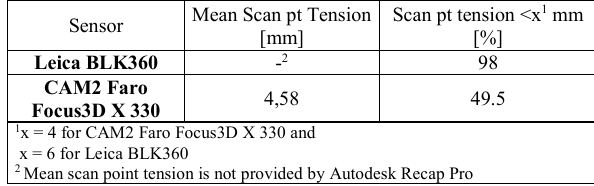
Table 7. Results of point tension between the clouds after the registration